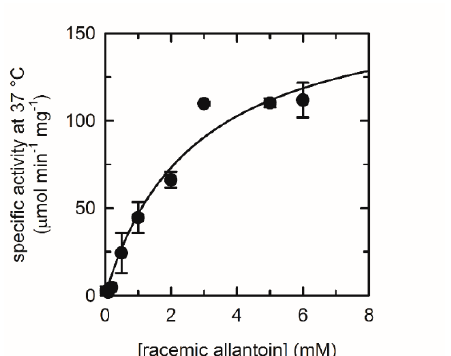
Figure 3. Michaelis–Menten dependence of puuE activity in the presence of increasing concentrations of racemic allantoin. Single-wavelength kinetics of (S)-allantoin consumption were recorded at 210 nm in 20 mM potassium phosphate, pH 7.4, at 37 ◦ C. Each point corresponds to a separate (S)-allantoin consumption kinetics; error bars represent standard errors of experimental replicates. Table 1. Catalytic parameters and catalytic e ffi ciency of free and encapsulated puuE on (S)-allantoin in 20 mM potassium phosphate, pH 7.4, at 37 ◦ C. For the free enzyme, k cat and K M values were obtained by fitting kinetic data to the Michaelis–Menten equation and the catalytic e ffi ciency was calculated as the ratio between the turnover number and Michaelis constant. Catalytic e ffi ciency for entrapped puuE was obtained on single kinetics in the presence of 40 µ M racemic allantoin, applying Equation (1). puuE k cat (s − 1